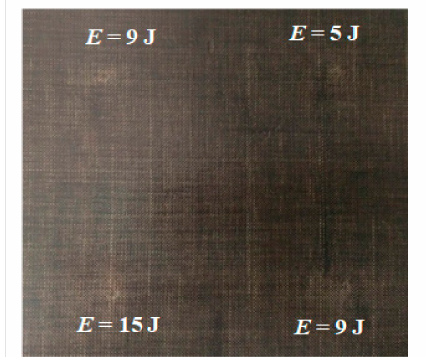
Figure 4. Photo of the polypropylene added with 2% maleic anhydride (PA6B) specimen with indicated energy and location of the impacts.